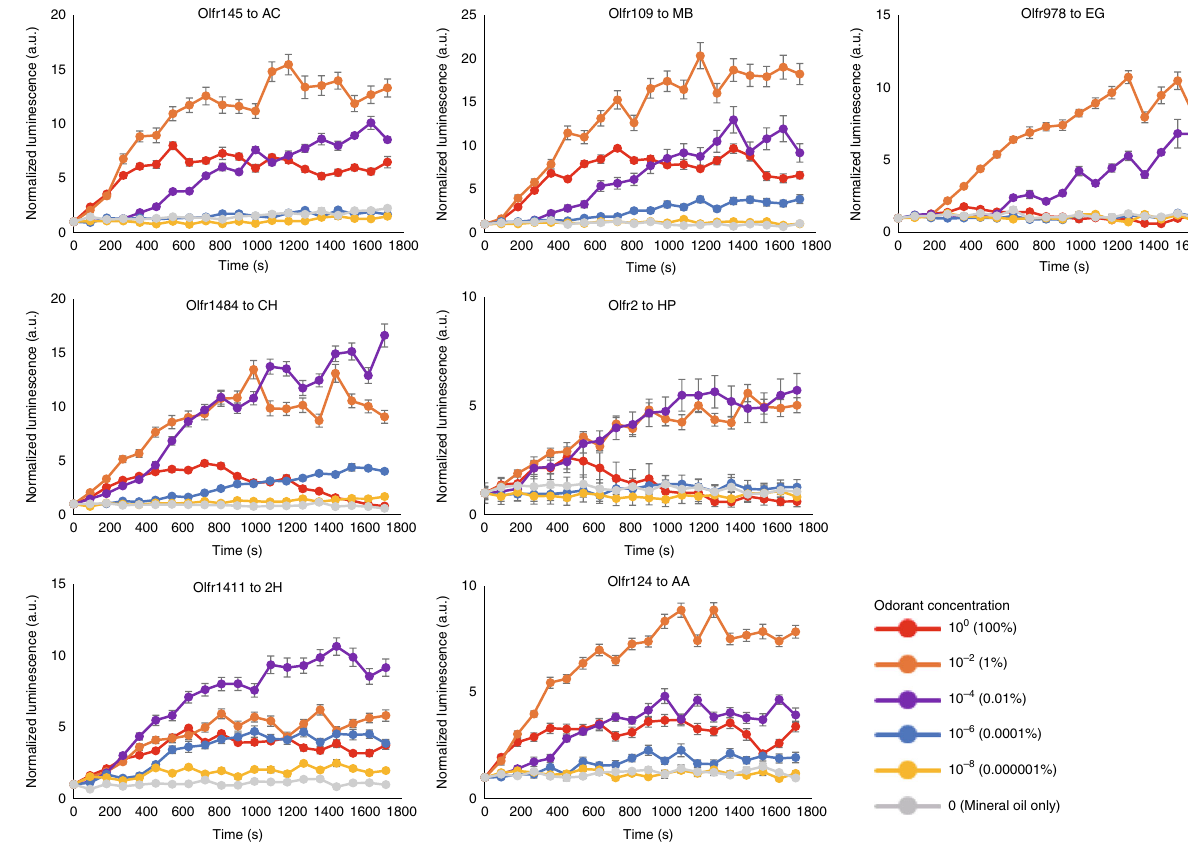
Fig. 4 Real time measurement of sensitive ORs for each odorant. Combinations of OR and abbreviations for the odorants are as follows; Olfr1377 to acetophenone (AC), Olfr109 to methyl benzoate (MB), Olfr978 to Eugenol (EG), Olfr1484 to cyclohexanone (CH), Olfr2 to heptanal (HP), Olfr1411 to 2- heptanone (2H) and Olfr124 to N-Amyl acetate (AA). The luminescence in each well was measured once every 90 s for 20 cycles. The luminescence was normalized such that the initial value of each receptor was de fi ned. Error bar indicated s.e.m. ( n =